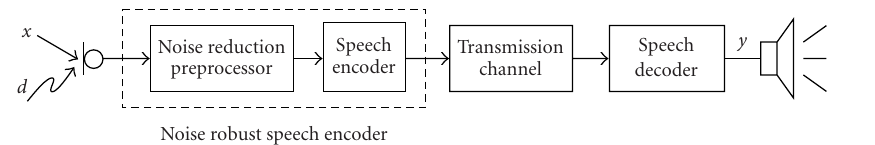
Figure 1: Speech communication system with noise reduction preprocessing.